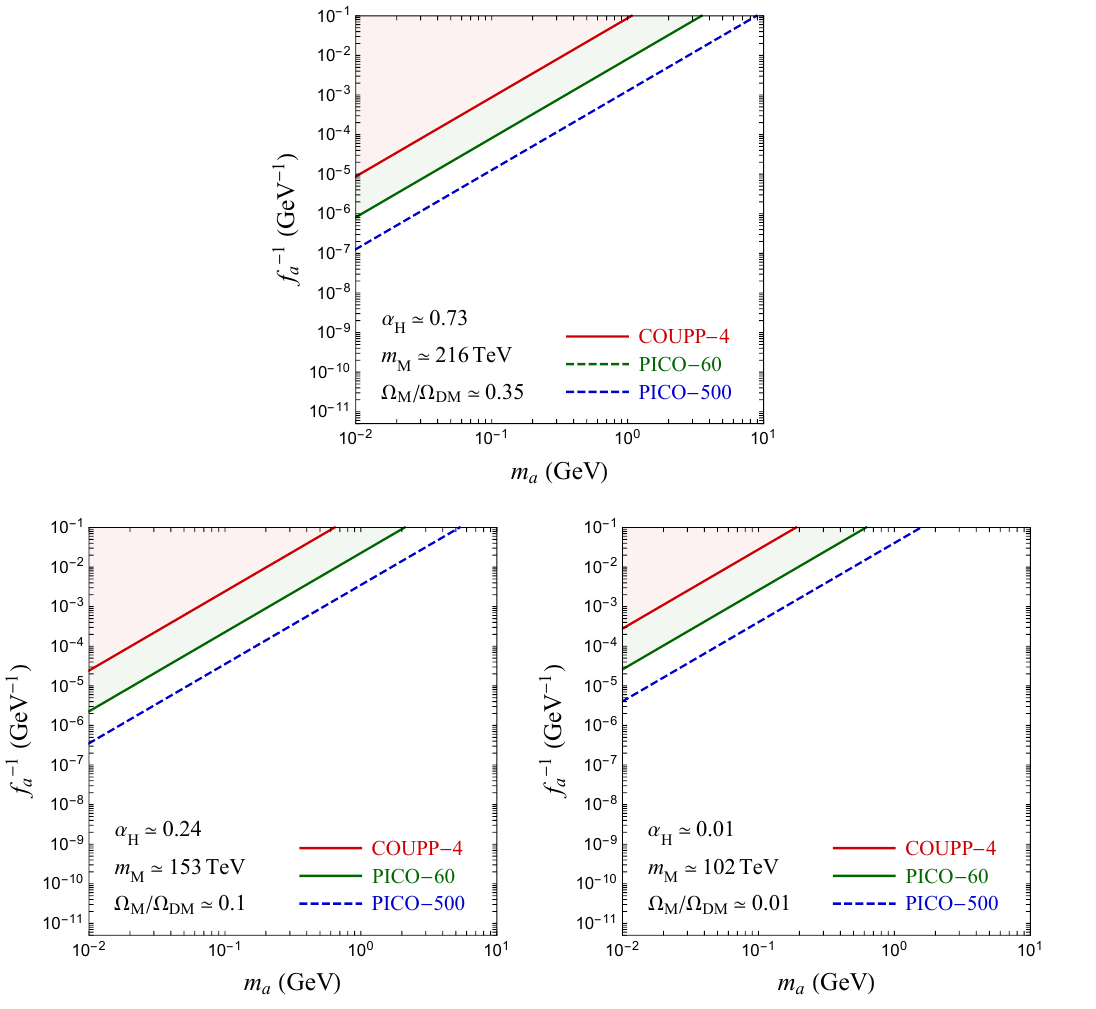
Figure 2 . The lower bound of the axion decay constant as a function of the axion mass by imposing the constraints from direct DM search experiments with di(cid:11)erent choices of (cid:11) red and green shaded regions are ruled out by the current experiments COUPP-4 and PICO-60, respectively, and the blue dashed line is the future sensitivity by PICO-500. The percentage of DM interacting with the nucleon is considered, which is indicated by the ratio (cid:10) M = (cid:10) DM in these plots. Here we have considered the case of proton and (cid:12)xed (cid:18) 0 =